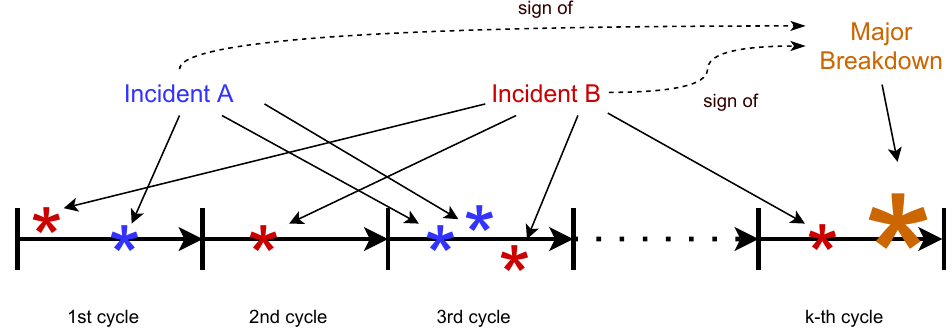
Figure 1. An illustration of minor and infrequent incidents in closed-loop IoT systems. Minor incidents show the sign of major breakdown. However, incidents caused by a minor abnormality are hard to detect unless with accumulative behavior